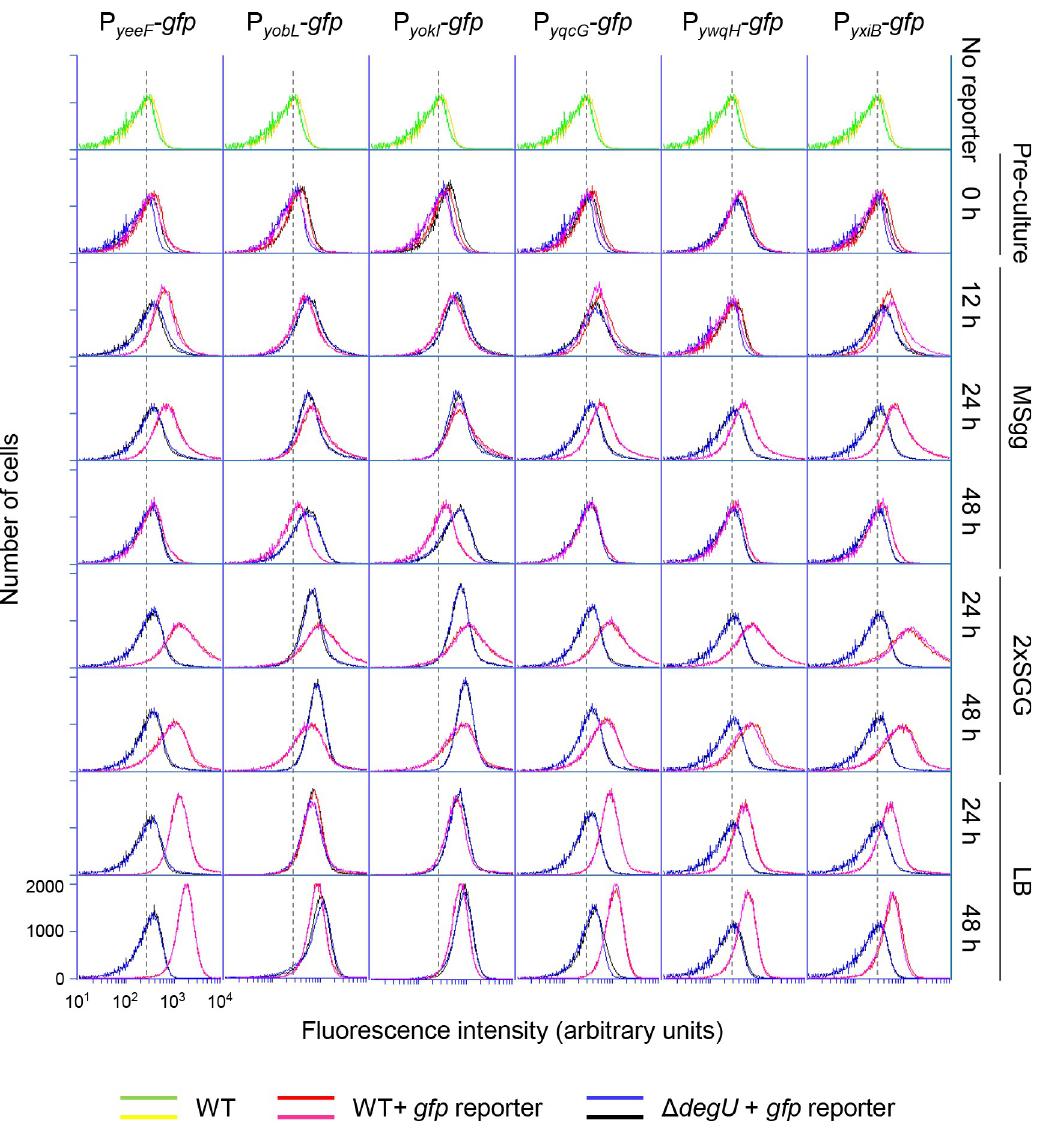
Fig 2. Expression of LXG toxin–antitoxin operons. Strains harboring promoter- gfp reporters were grown to an OD 600 of 0.7 to 0.8 in liquid LB (preculture, 0 h). The cultures were diluted to an OD 600 of 0.5, and 2 μ l of the dilutions were spotted on three solid media, MSgg, 2 × SGG, and LB. After 12 h, 24 h, or 48 h of incubation at 30˚C, expression of gfp reporters in colonies were measured by flow cytometry. Strain 3610 (with no gfp reporter) was used as a negative control. Two sets of data are shown for each strain. All histograms are shown on the same scale, and values for the x and y axes are shown only in the lower left histogram. The peak positions of fluorescence from strain 3610 are indicated as a background reference by dotted lines.